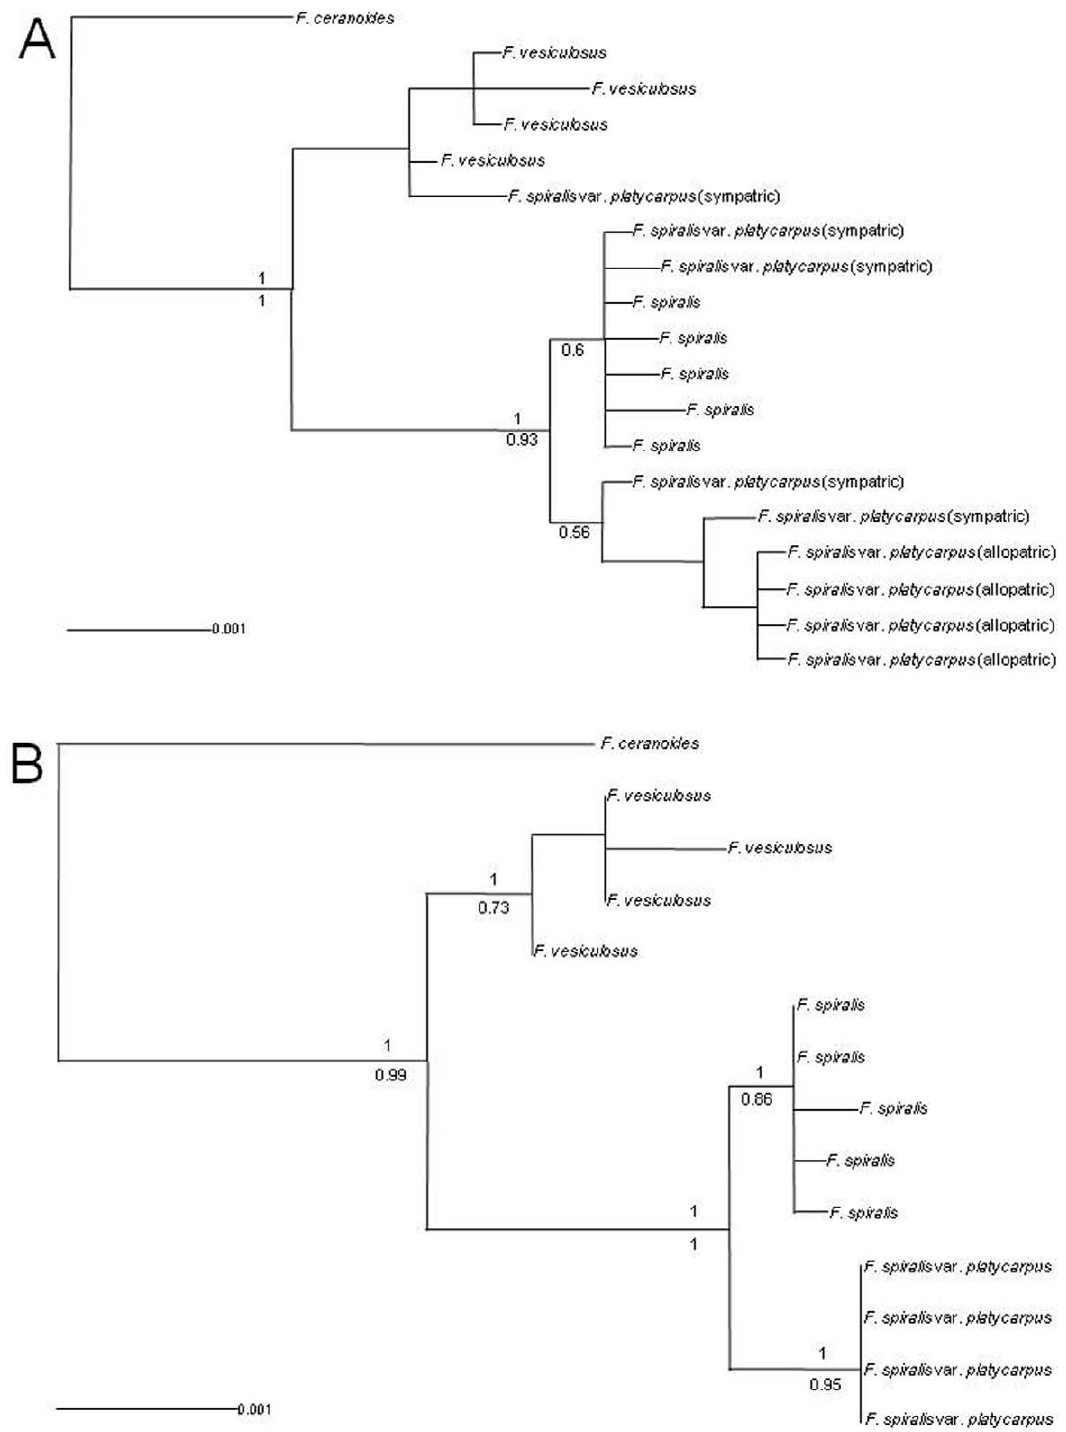
Figure 4. Phylogenetic tree. Phylogenetic relationships between Fucus morphotypes when F. spiralis var. platycarpus populations occur in sympatry and allopatry (a) or only in allopatry (b). Both the 50% majority rule percentage of support for clades given by Bayesian posterior probabilities from one million generation MCMC analysis (above) and the 50% majority rule consensus tree of maximum likelihood bootstrap (below) based on the 14 coding regions used. Both trees were rooted using F. ceranoides as outgroup species. doi:10.1371/journal.pone.0019402.g004 level of reproductive isolation between F. spiralis and F. vesiculosus differentiate these two species. Moreover, the allopatric F. spiralis across geographical sites [35]. The SNP loci we used for this study, var. platycarpus from southern Iberia [which corresponds morpho- recently developed from EST collections [73], unambiguously logically with F. spiralis Low as identified by Billard et al. [39]]